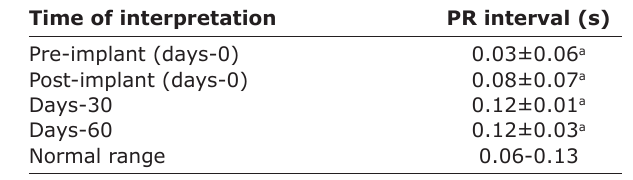
Table-8: The average of PR interval of the pigs.